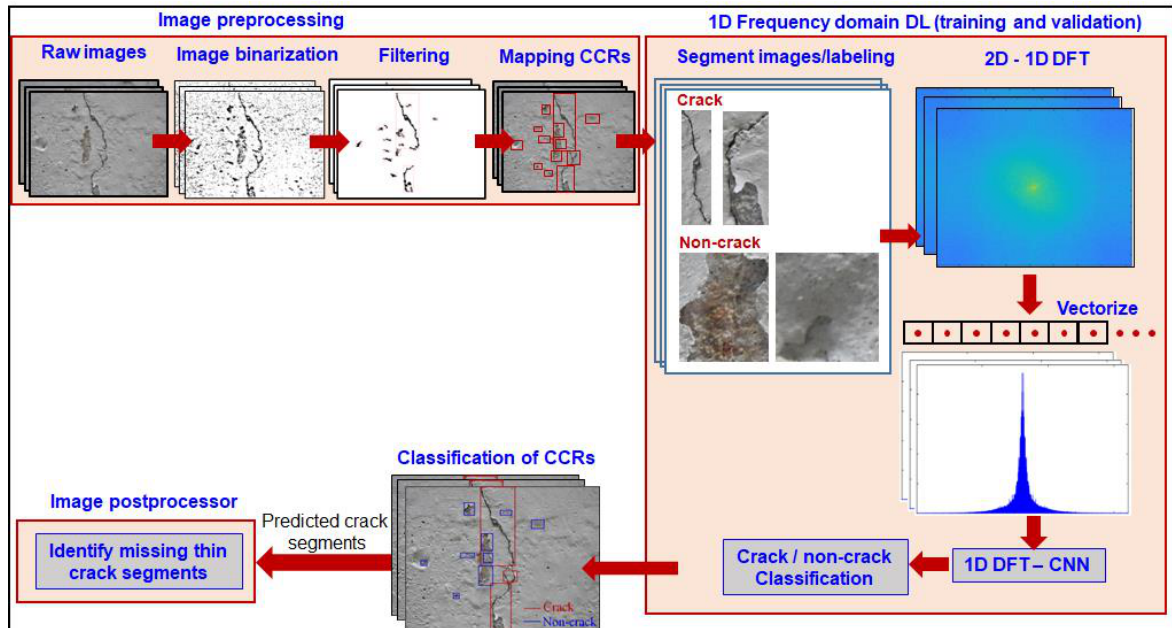
Figure 3. Overall algorithmic scheme for identifying thin propagating cracks, wherein image processing is used as a preprocessor and postprocessor to 1D frequency-domain-based deep learning (DL).